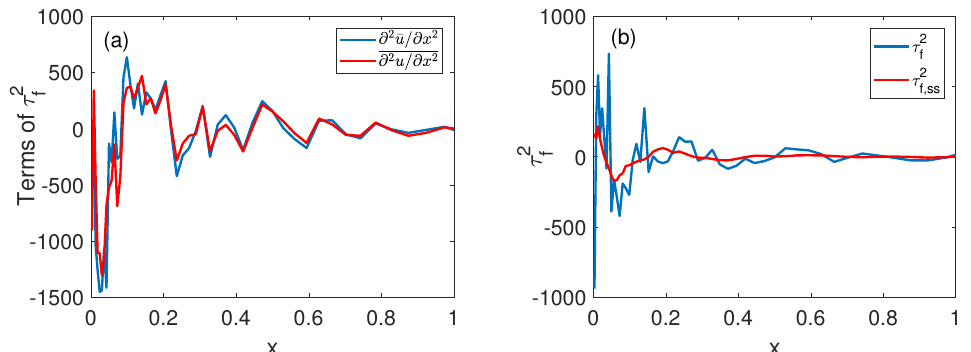
Figure 4. ( a ) (Filtered) second derivatives of the data (filtered data) shown in Figure 2. ( b ) Commu- tation error given by ∂ 2 u / ∂ x 2 − ∂ 2 u / ∂ x 2 together with scale similarity model for the commutation error, given by Equation (47) using C = 1.